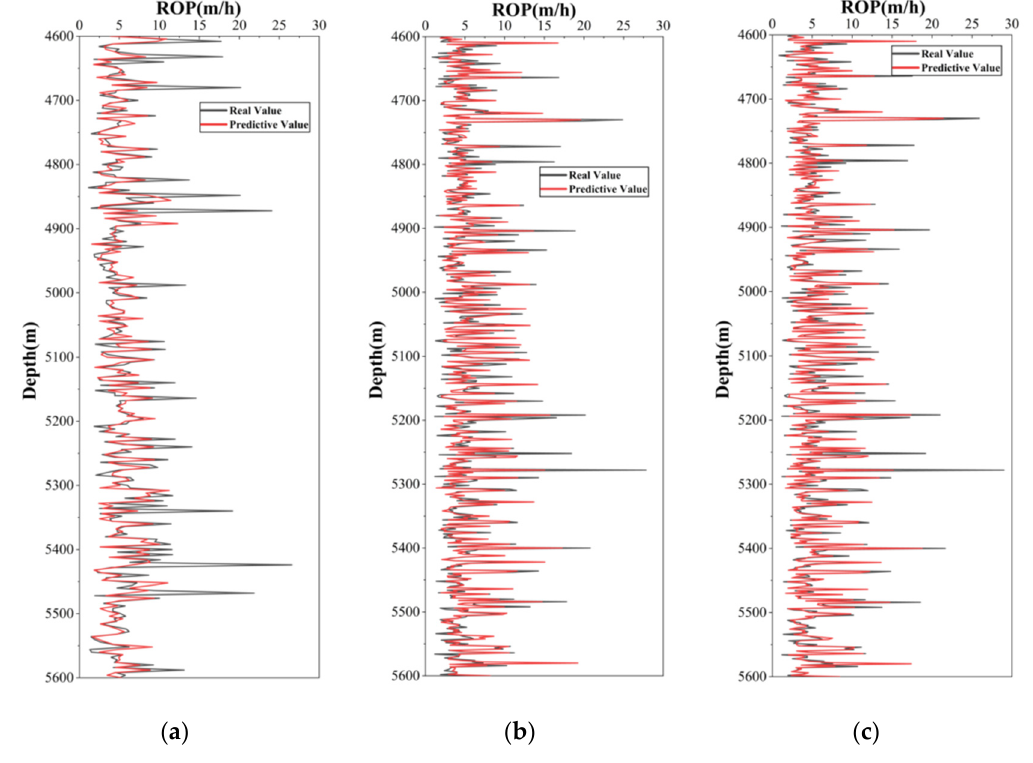
Figure 8. ROP prediction results on test set 2: ( a ) ROP prediction results of FNN model; ( b ) ROP prediction results of LSTM model ; ( c ) ROP prediction results of LSTM-FNN model Table 4. Precision comparison of ROP prediction models.